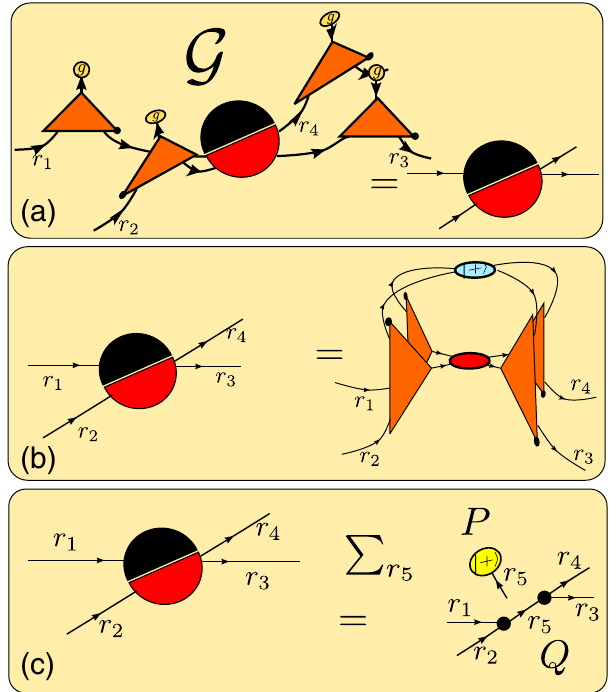
FIG. 15. (a) The tensor G that is used to build the projector onto the physical Hilbert space is an invariant tensor under the action of G , as defined in Eq. (8). The legs of G carry an index of the irrep, since the Hilbert space on which they act has a direct sum structure labeled by the irrep r . (b) G can be obtained by using the explicit form of the projector onto the trivial irrep (9). The red circle is the copy tensor in the group algebra. After acting with the projector, we have to take an equal superposition of all vectors in the trivial irrep space, so as to obtain P . This equal superposition T requires finding the image of the projector, taking an equal superposition of vectors spanning such an image state that we represent by the cyan jþi , and contracting on it all open legs. (c) Alternatively, one can use the construction introduced in Ref. [58] for building symmetric tensors. The tensor is then divided into a piece Q that takes care of correctly matching the various irreps (made by the Clebsch-Gordan coefficients) and a degeneracy tensor P , made of free parameters, that assigns a four-leg tensor to each of the irreps which enter in composition of representations. In the example we draw, P depends on the irreps r 5 that are contained into the tensor product of r 1 and r 2 . Once more, the projector P is obtained by taking a uniform superposition of the T possible values of r 5 , that is, setting P ¼ jþi